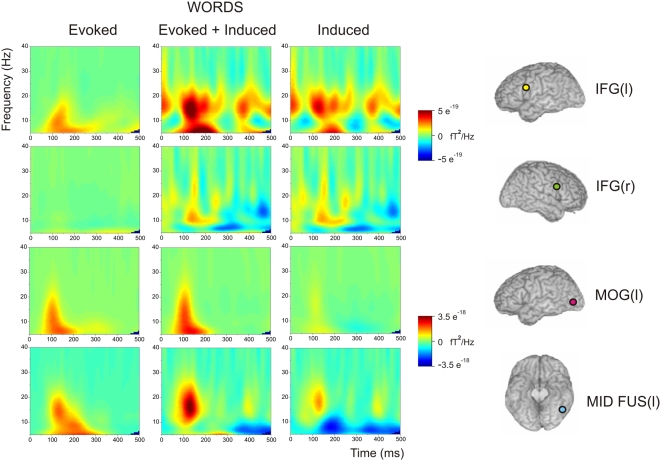
Shows time frequency plots for all four ROIs for all participants' responses to words.The left column represents evoked activity, the middle column presents evoked plus induced activity, while the right column represents induced activity alone.